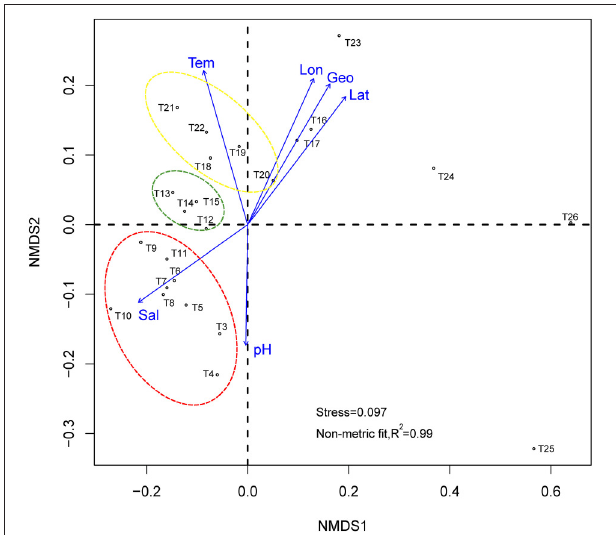
FIGURE 3 | Non-metric multidimensional scaling based on Bray-Curtis community distances. Arrows show vector fitting of the environmental variables. Stations in yellow circle are located at semi-close marginal seas, those green, and red circles are located at Indian Monsoon Gyre Province and Indian Subtropical Gyre Province respectively. Tem, Temperature; Sal, salinity; Geo, geographic distance; Lon, longitude; Lat, latitude.